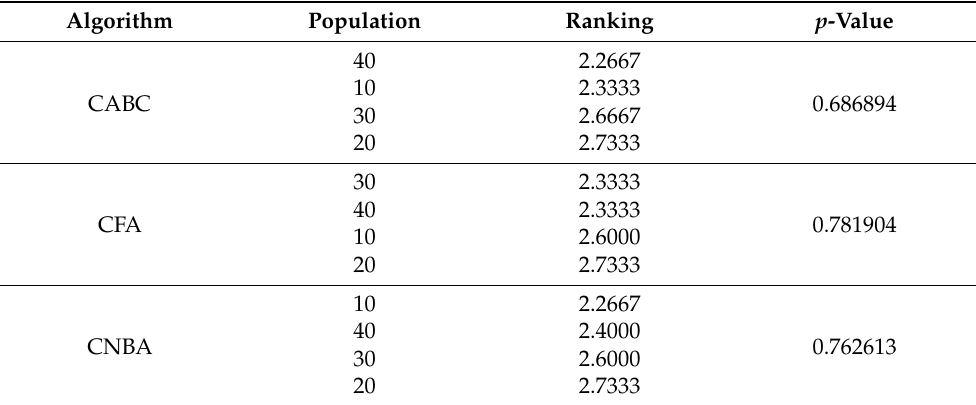
Table 4. Ranking of Friedman test comparing the results of the proposed algorithms with different population size, according to the ARI measure.